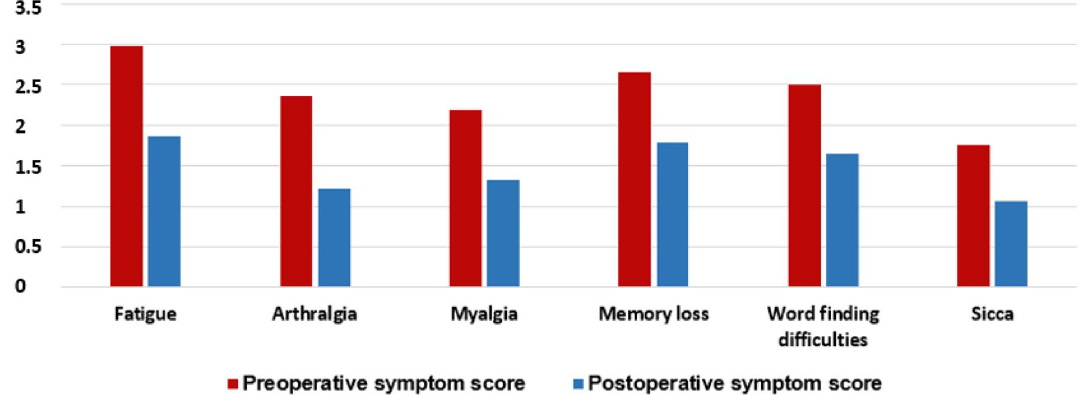
Figure 1. Comparison of preoperative vs. postoperative ASIA major criteria clinical manifestations mean symptom scores in the symptomatic group (n = 98) using Wilcoxon Signed-Ranks test ( p < .001).